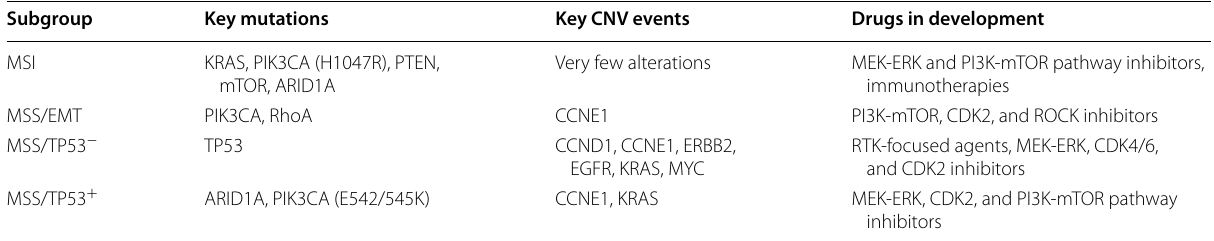
Table 2 Summary of clinically relevant and actionable genomic alterations and molecular subtypes of GC